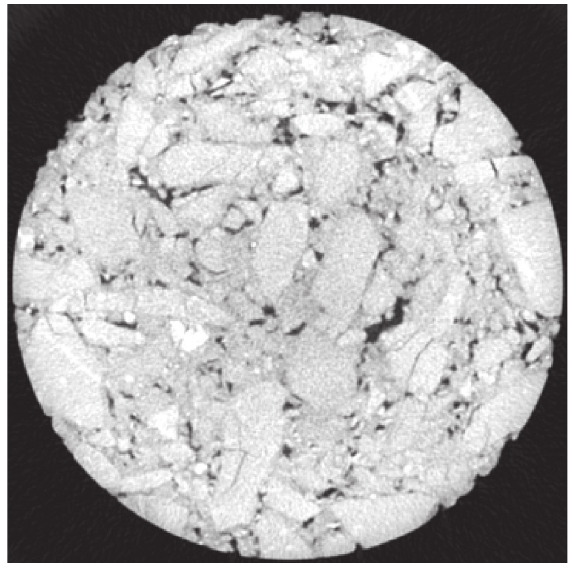
Figure 9: The processed gray image.